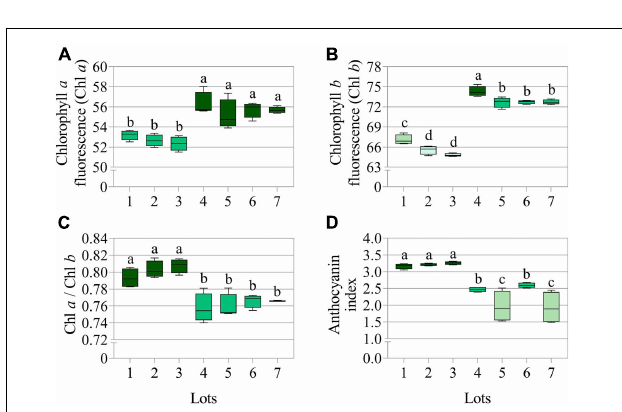
FIGURE 3 | Average chlorophyll a fluorescence (Chl a ) at 630/700 nm excitation/emission combination (A) , chlorophyll b fluorescence (Chl b ) at 405/600 nm excitation/emission combination (B) , chlorophyll a/b ratio (Chl a /Chl b ) (C) , and anthocyanin index (D) measured in seven seedlots of